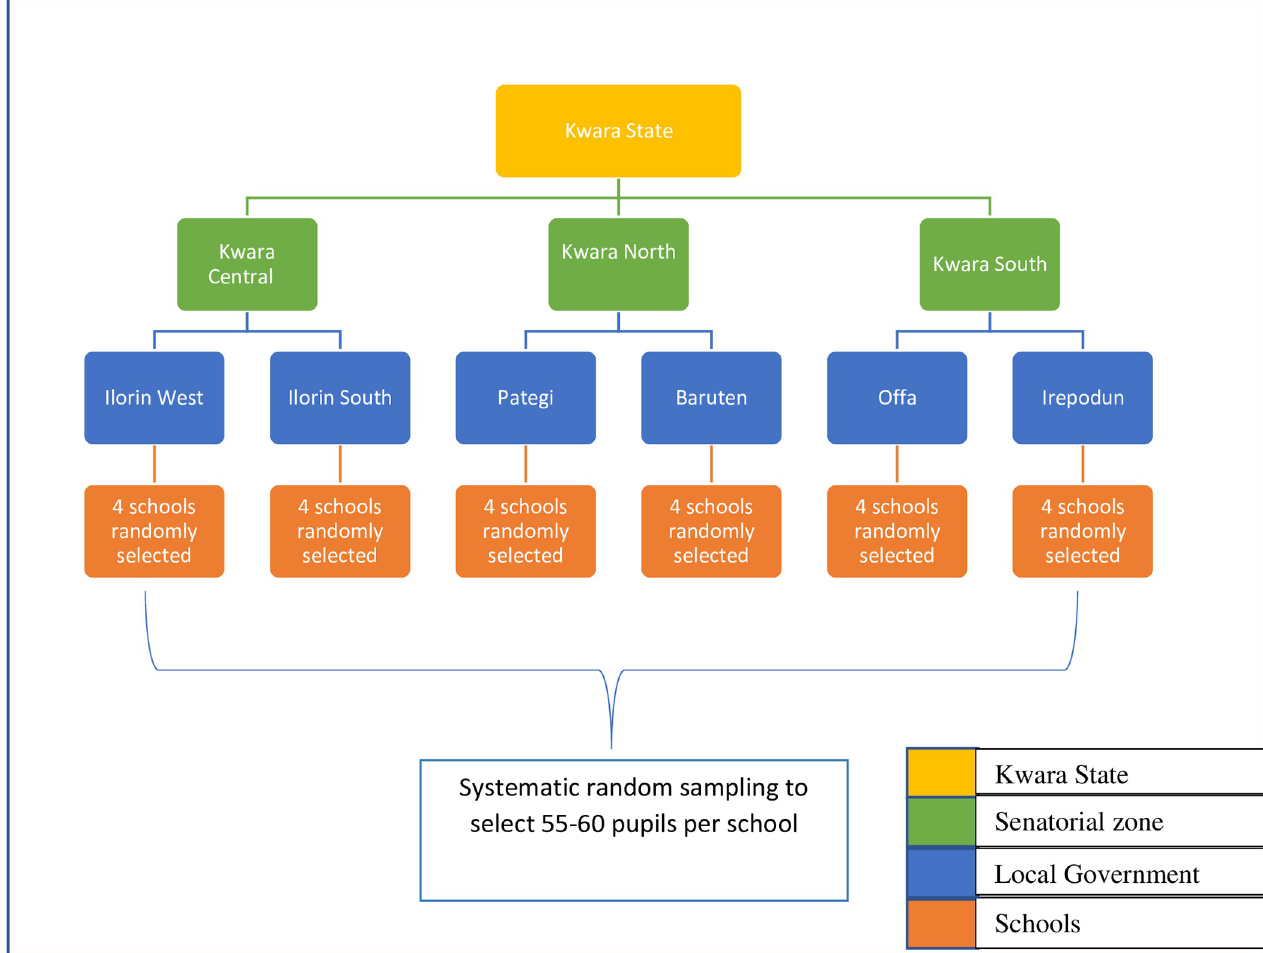
Fig 1. A multistage sampling of pupils across Kwara State.